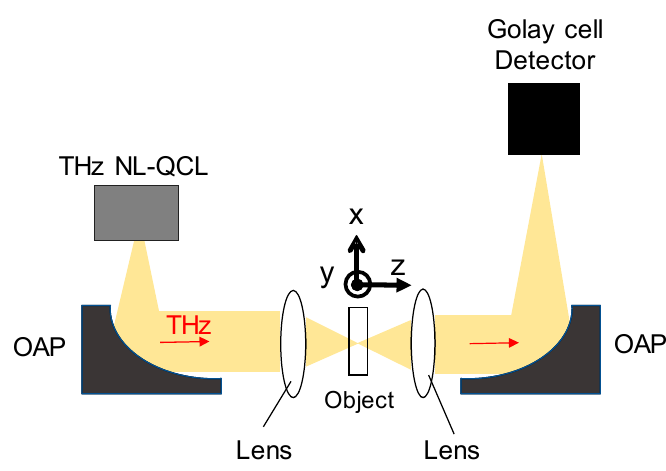
Figure 2. THz transmission imaging system.